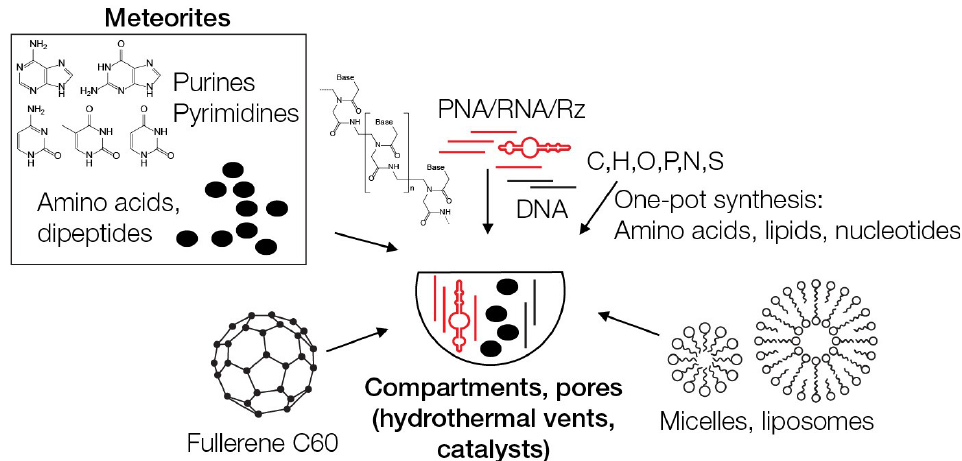
Figure 1. Building blocks of life. Some were identified in meteorite samples, such as amino acids, dipeptides, and nucleotide-like molecules. The most abundant elements in present-day biomolecules are C, H, O, P, N and S. Life may have started close to hydrothermal vents that provided thermal the energy required to accelerate chemical reactions. There, compartments such as pores may have helped to concentrate substrates for more complex compounds to form, and catalysts may have included metal cations that today are crucial cofactors in many biological processes. PNA, peptide nucleic acid.